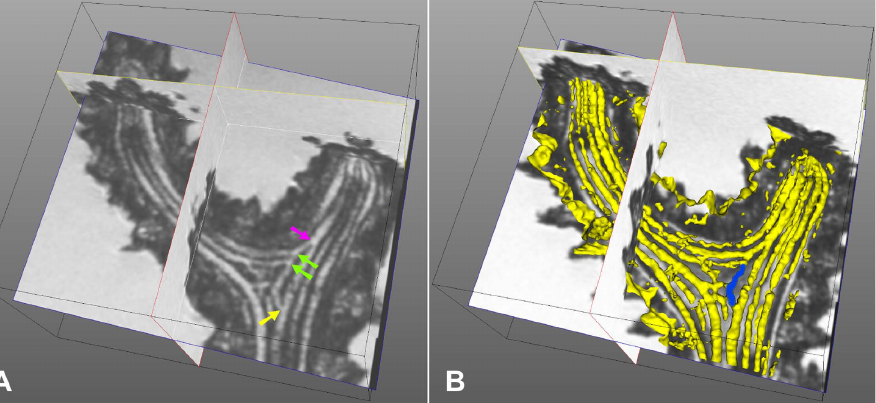
Figure 15. Example of a complex canal configuration in a branching region. (A) longitudinal slightly oblique slice from the original image, (B) attempt to 3D surface rendering of the canals present in this region. A canal bifurcates (yellow arrow) giving rise to a secondary pathway that successively joins two canals coming from a colony branch (green arrows) and finally joins the principal canal again (magenta arrow). The secondary pathway highlighted in blue on the 3D rendering cannot be extracted with the current version of our method, but was noticed when visually following the extracted pathways.